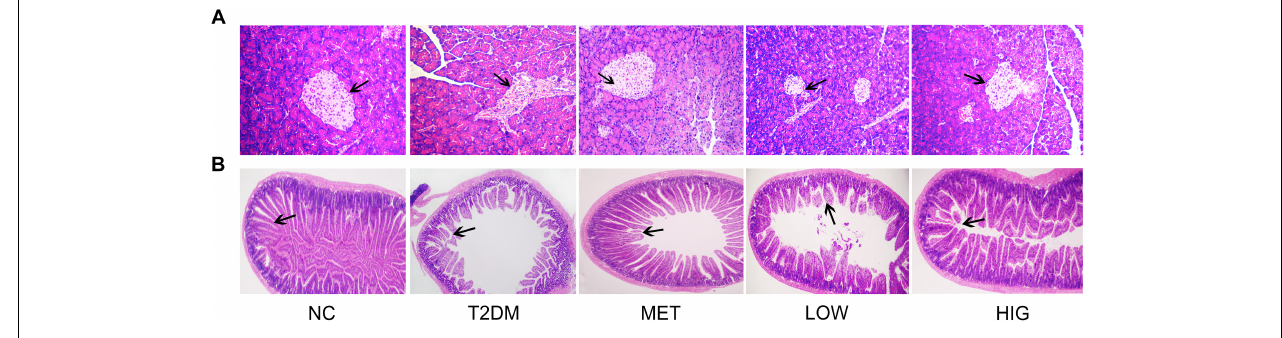
FIGURE 3 | Effects of RAGP on histopathological analysis. (A) Pancreas tissues stained with H&E (100 × ); (B) ileum tissues stained with H&E (25 ×